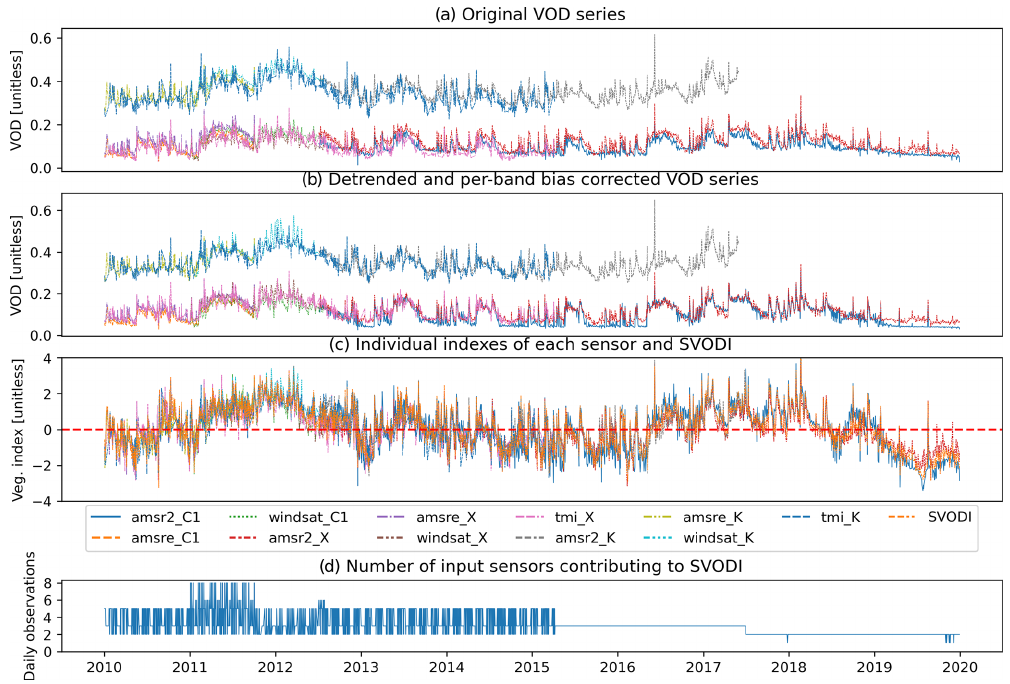
Figure 3. Temporal subset of an example time series at different processing stages in Western Australia (24.9 ◦ S, 125.625 ◦ E), located in the Gibson Desert Nature Reserve. The vegetation is shrubland with sparse trees. (a) Original VOD time series. (b) The same VOD series after bias correction. Note that only the bias within each band is corrected and not to a common reference for all bands. (c) The indices created from each sensor and band as well as SVODI. (d) The number of observations contributing to a SVODI value for each day.